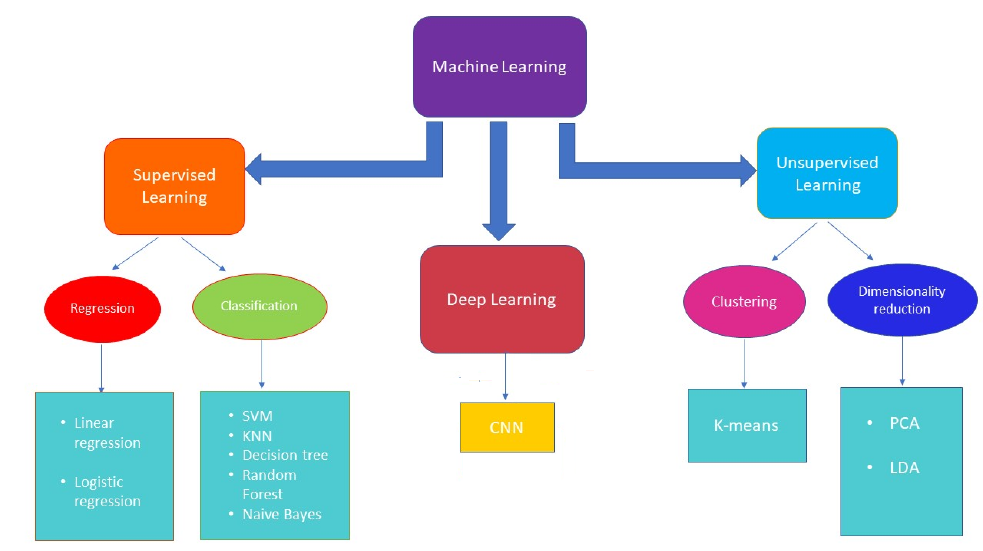
Figure 1. A possible schematization of machine learning